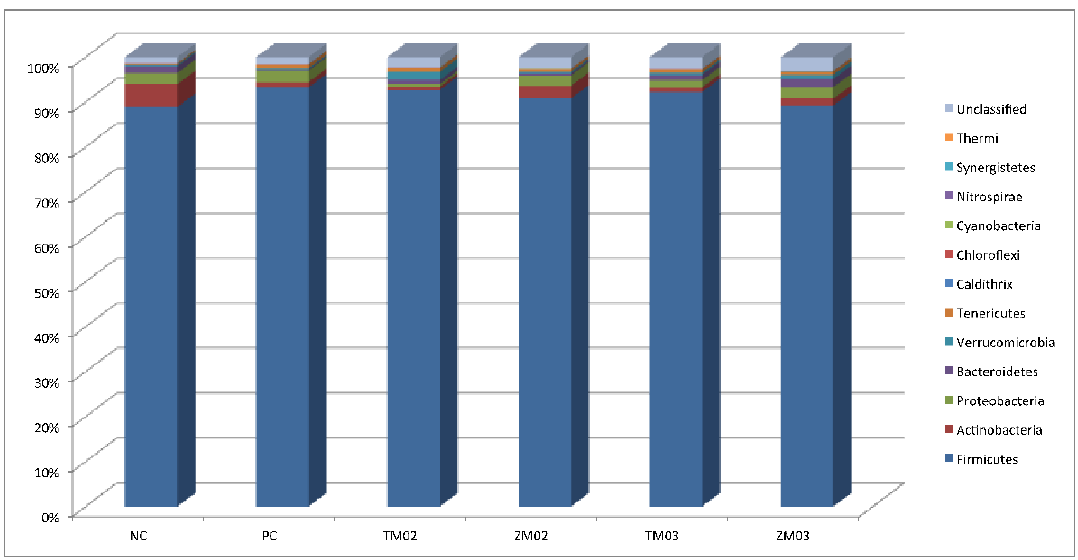
Figure 3. Effect of insect diet on chicken cecal microbiome composition at phylum - level. Legends refer